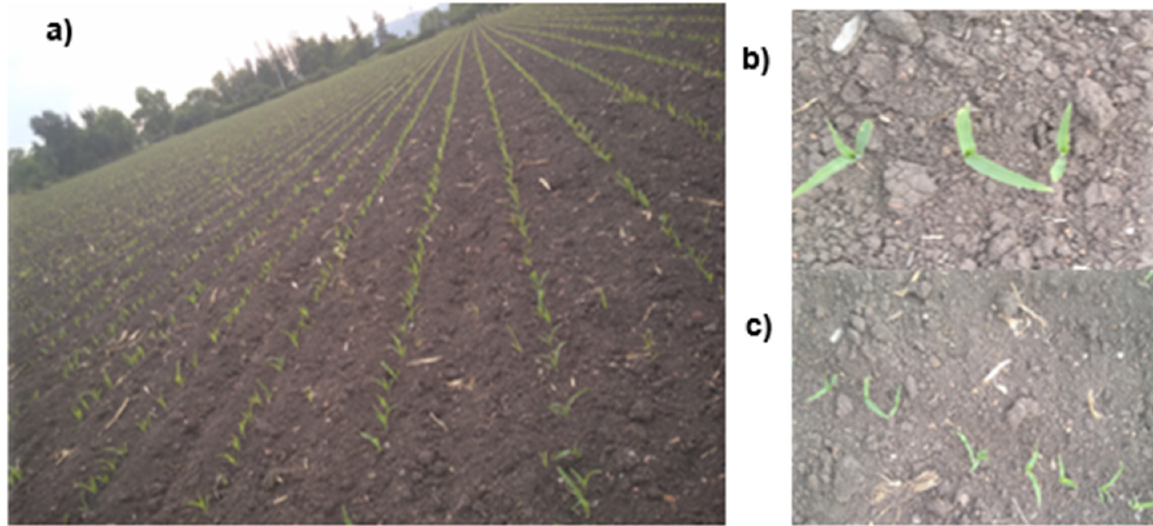
Figure 2. Taking photographs: ( a ) panoramic, ( b ) point and ( c ) overhead.